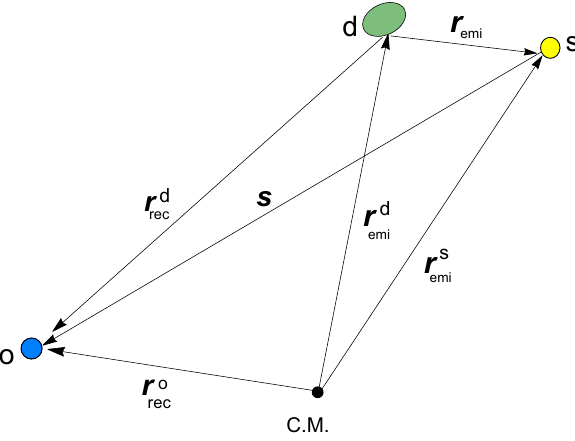
Fig. 4 Vectors connecting the source s and the deflector d at t emi , and the observer o at t rec . The symbols adopted differ from those used in, e.g., [55]. The origin O coincides with the binary’s center of mass